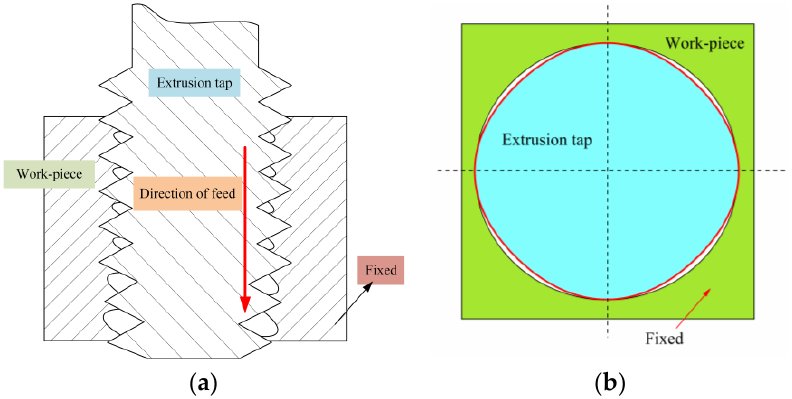
Figure 1. The principle of extrusion tapping in ( a ) and the working section of the tap in ( b ).